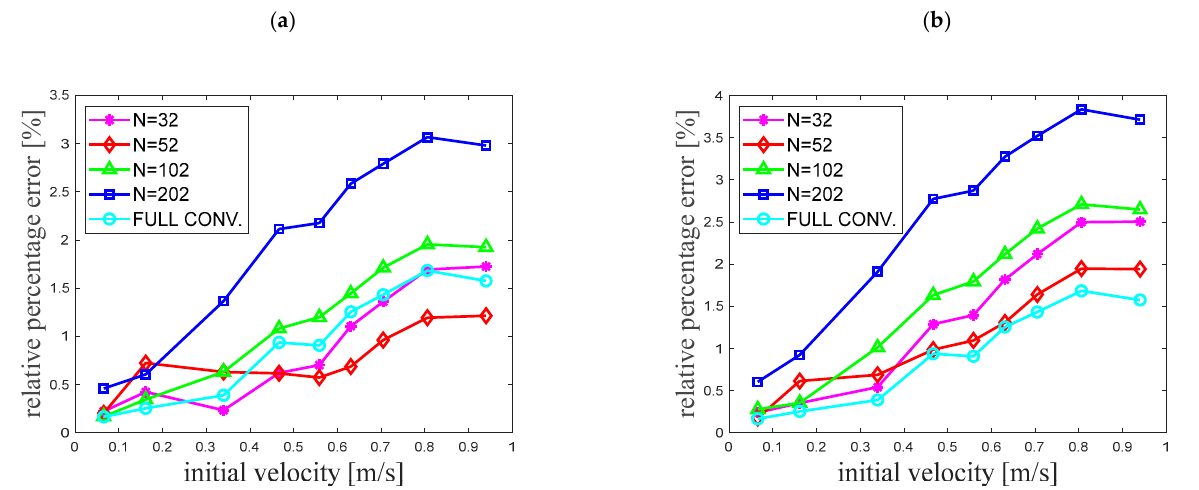
Figure 9. Variation in Ep error coefficient for: ( a ) standard method (SM); ( b ) lumped friction method (LFM). Table 3. Quantitative results of the Et coefficients.